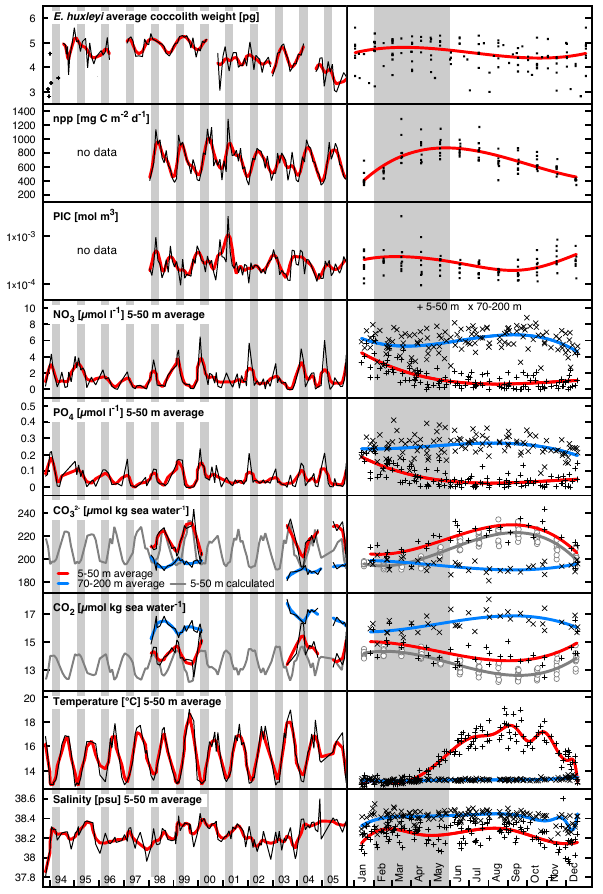
Figure 4. Emiliania huxleyi coccolith weight versus environmental data. Left: time period from 1993 to 2005 during which additional data was available. Thin lines represent original data, bold colored lines are fast Fourier transform smoothed data. Right: data as on the left plotted on a composite year, indicating seasonal trends. Bold lines represent spline fits. Grey bars indicate the time period from February to May.